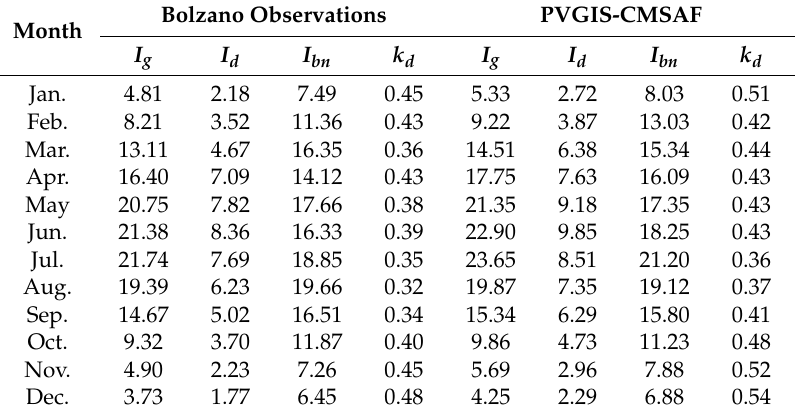
Table 2. Comparison of monthly mean global, diffuse, and beam (normal) daily irradiations ( I g , I d , and I bn ), as well as daily diffuse fractions ( k d ), calculated from Bolzano experimental data and extracted from PVGIS-CMSAF